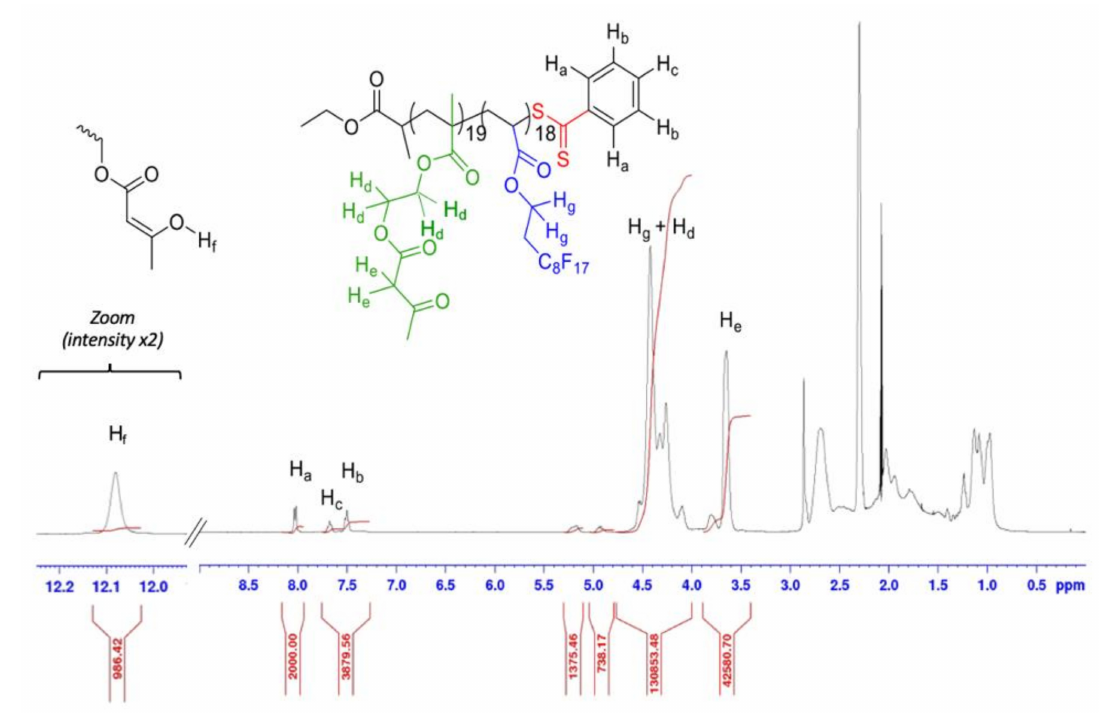
Figure 4. 1 H-NMR spectrum (400 MHz, acetone-d 6 ) of P(AAEM- co -FDA) after precipitation.